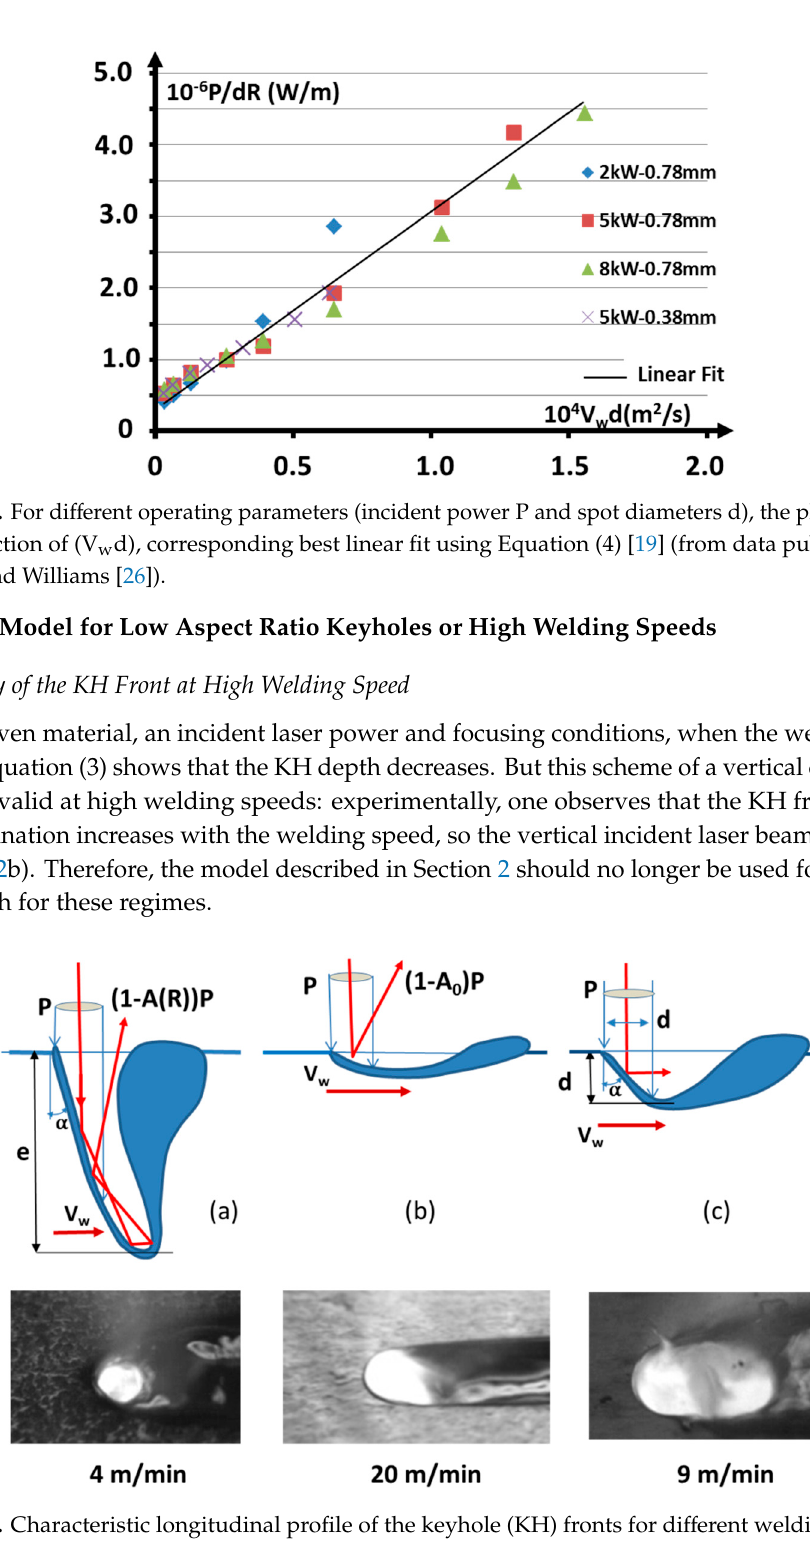
Figure 2. Characteristic longitudinal profile of the keyhole (KH) fronts for different welding speeds. ( a ) At low welding speed, a KH with a high aspect ratio R is obtained due to multi-reflections inside it. ( b ) At high welding speed only the KH front is irradiated; the reflected beam is directed upwards. ( c ) At KH threshold, (R = 1), the reflected beam is horizontal and interacts with the KH rear wall. Corresponding views of the KH aperture (d = 0.6mm, P = 4 kW; 316L material) [28].